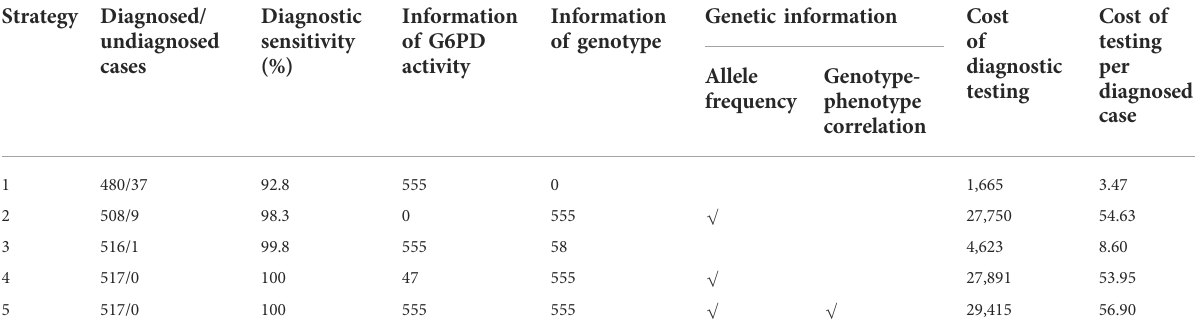
TABLE 4 Cost analysis of different strategies for the diagnosis of G6PD de fi ciency and female heterozygotes from infants with positive newborn screening results. Strategy Diagnosed/